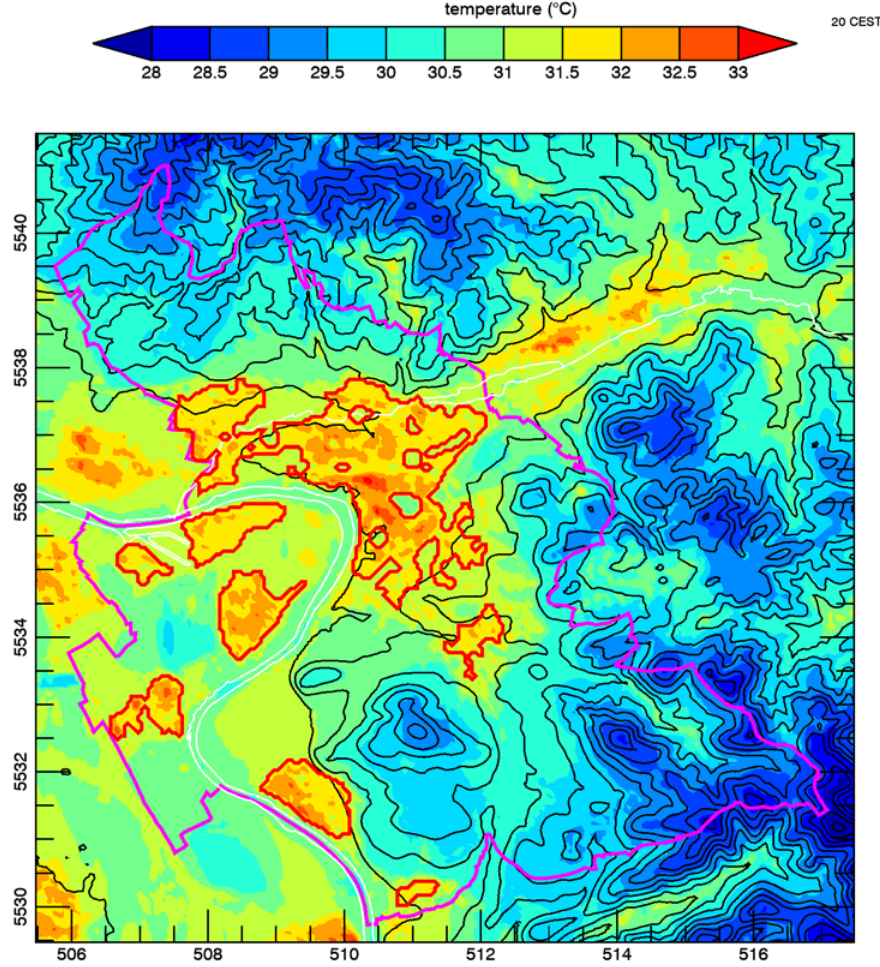
Figure 6. Temperature map (°C) at 5 m above ground level of the 12 km × 12 km city subdomain at 20:00 CEST with thermal hot spots (THs) determined by z-transformation (red contour lines). Terrain elevation contour lines are shown in black, rivers in white and the city border of Aschaffenburg in magenta.